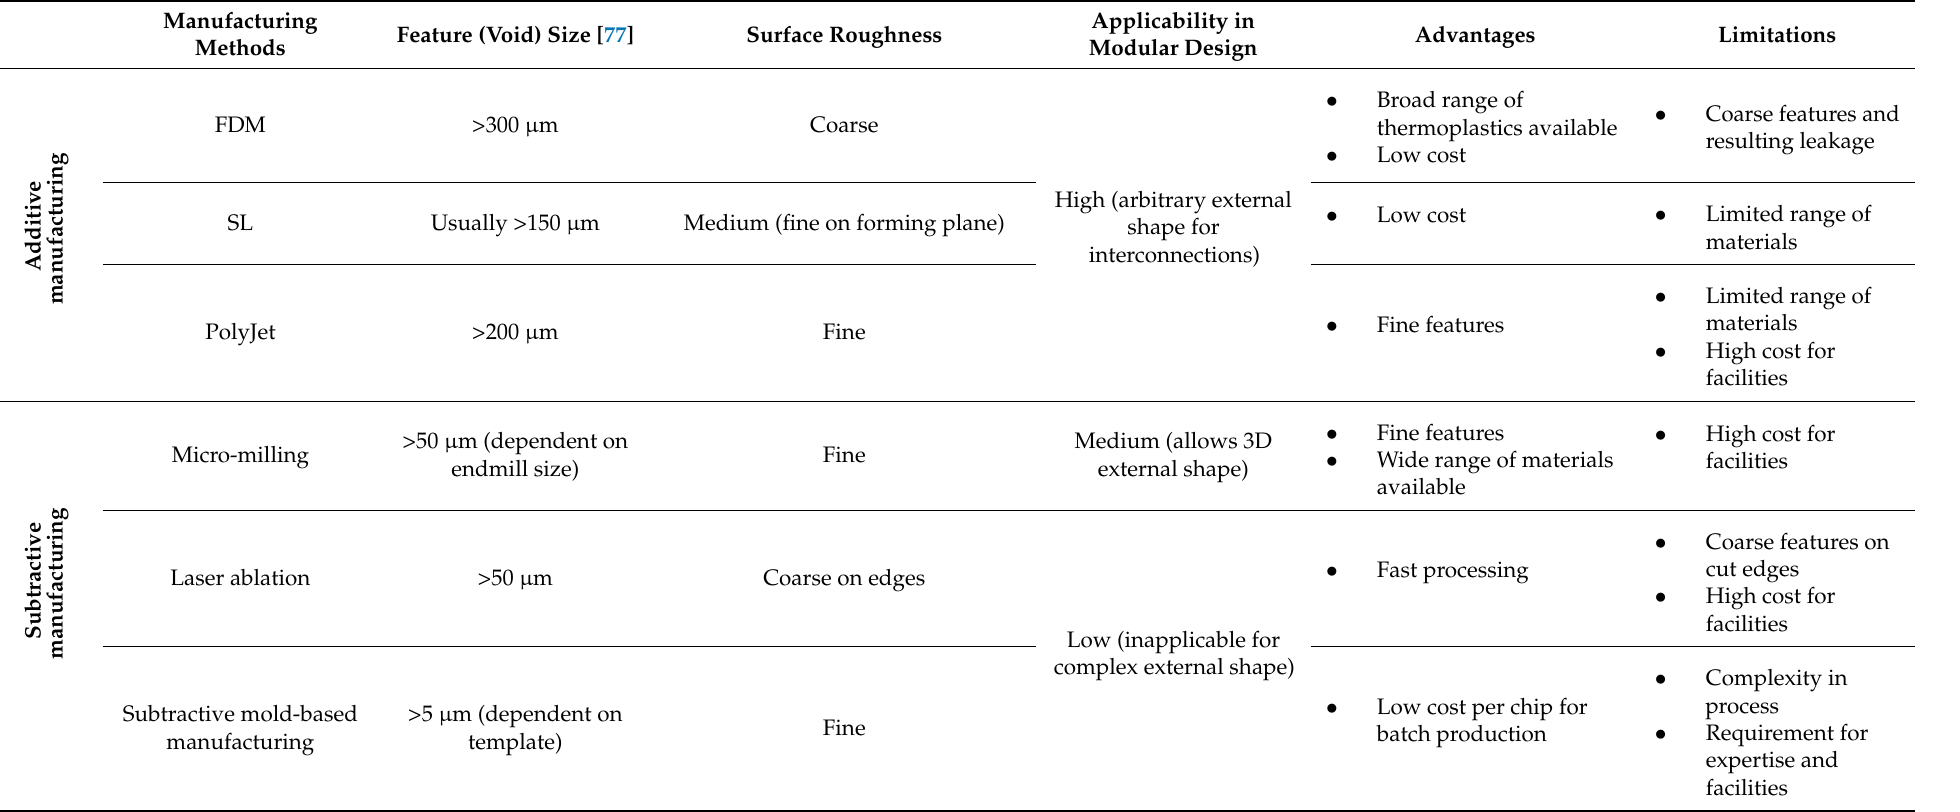
Table 1. Comparison of different manufacturing techniques for microfluidic